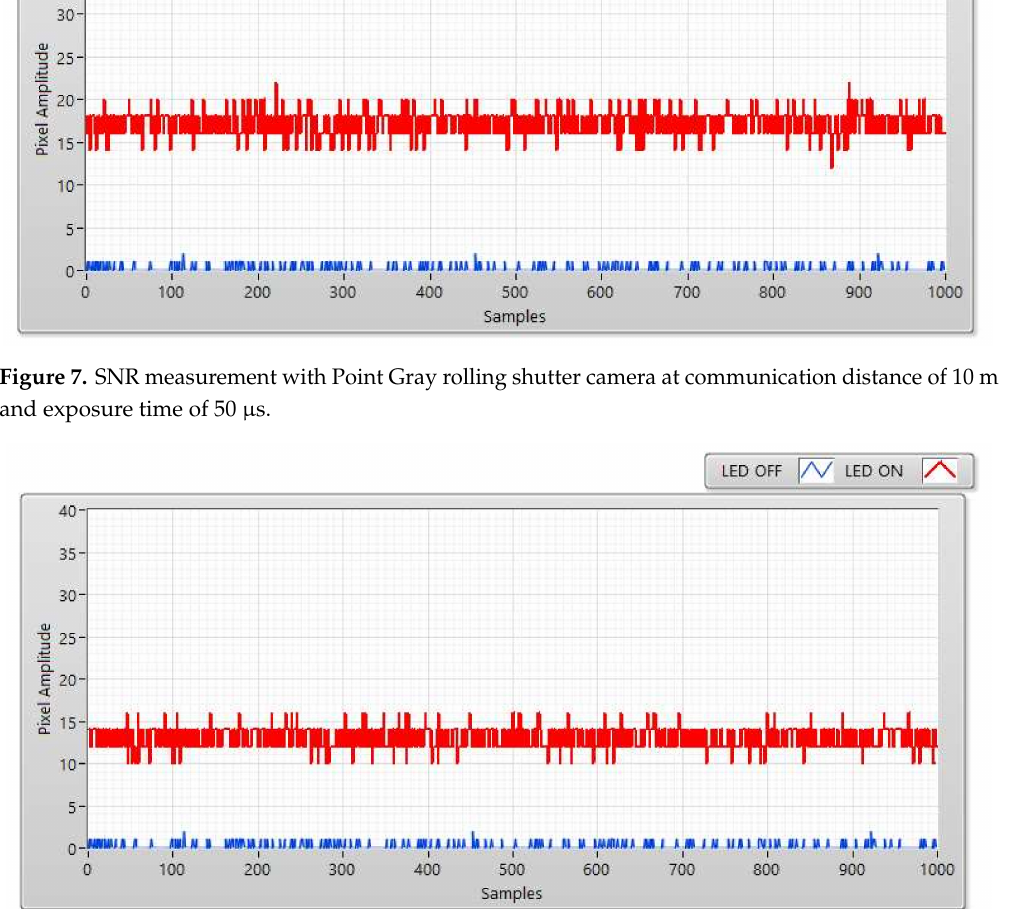
Figure 8. SNR measurement with Point Gray rolling shutter camera at communication distance of 15 m and exposure time of 50 µ s.